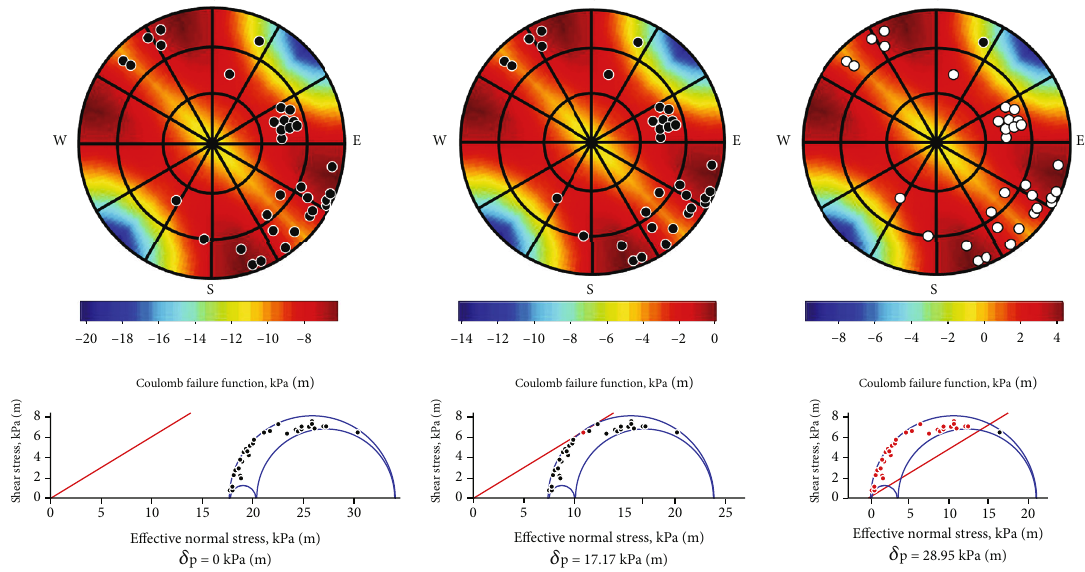
Figure 11: Lower hemisphere stereonet plots and Mohr ’ s circles analyzing natural fracture reactivation risks in Well Hb2 of Haiba